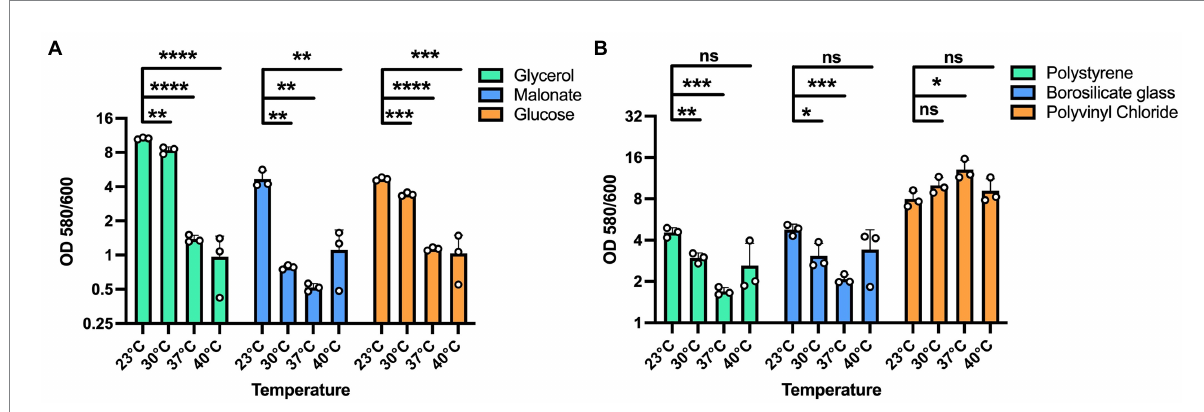
FIGURE 2 Effect of different substrates and materials on temperature-dependent biofilm formation. (A) The overall biofilm trend was same for all the carbon sources used. A 100 mM concentration of each carbon source in M9 media was used for biofilm growth at each temperature. In all cases, biofilm formation was most robust at 23 ° C and displayed decreasing levels with increasing temperatures. (B) The trend of higher biofilm formation at lower temperatures is observed on polystyrene and borosilicate glass. However, on polyvinyl chloride urinary catheters, biofilm formation was generally robust at all temperatures with a statistically significant advantage at 37 ° C. Bars represent the mean of three biological replicates performed on different days. The mean of each biological replicate was based on three technical replicates. Error bars represent the standard error of mean of the biological replicates. Unpaired t-test (two-tailed) was used to measure statistical significance. Y-axis is scaled by log2. ns: not significant, * p ≤ 0.05, ** p ≤ 0.01, *** p ≤ 0.001, and **** p ≤